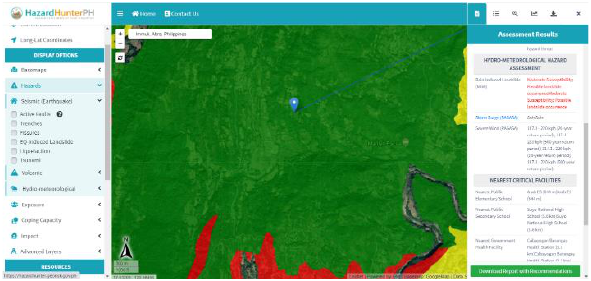
Figure 1 . Landslide hazard in Brgy. Immuli,